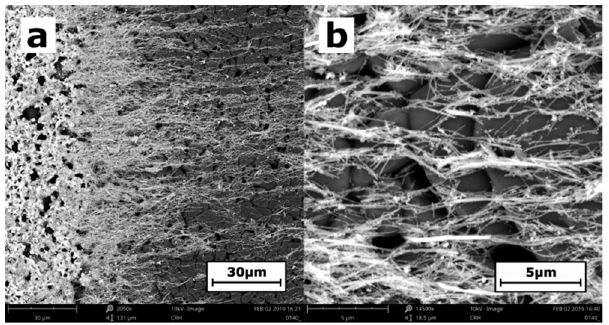
Figure 2. Typical SEM micrograph of aligned SbSI nanowires ( a ) near Pt electrode (left side) and ( b ) between electrodes on Al 2 O 3 substrate.